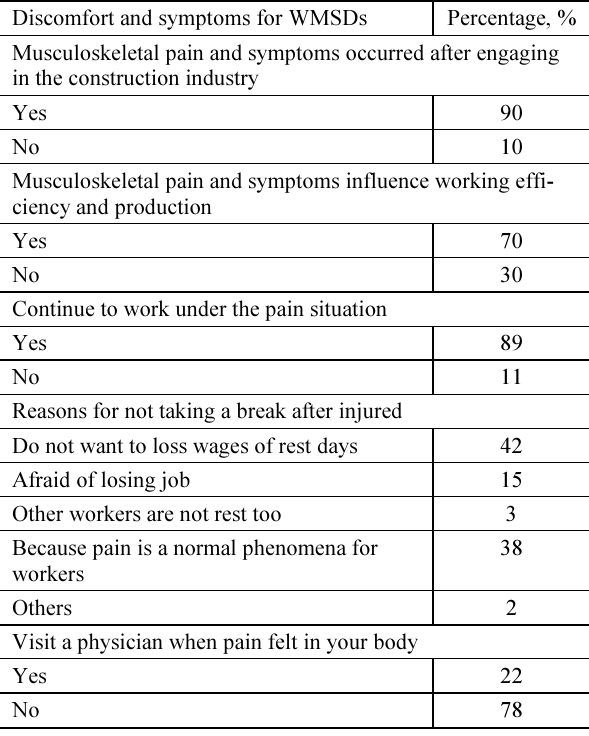
Table 2. Survey of the workers’ discomfort for work-related